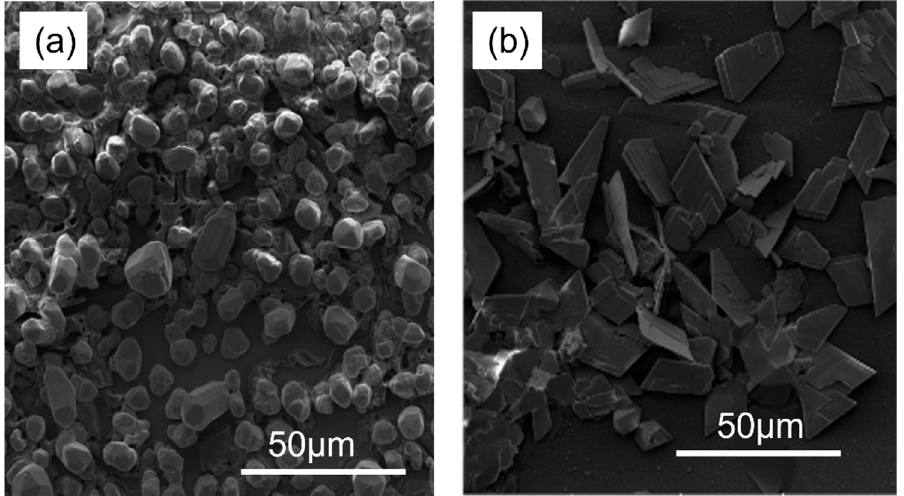
Figure 6. SEM images of ( a ) Ag and ( b ) Pb deposed on FTO substrate.